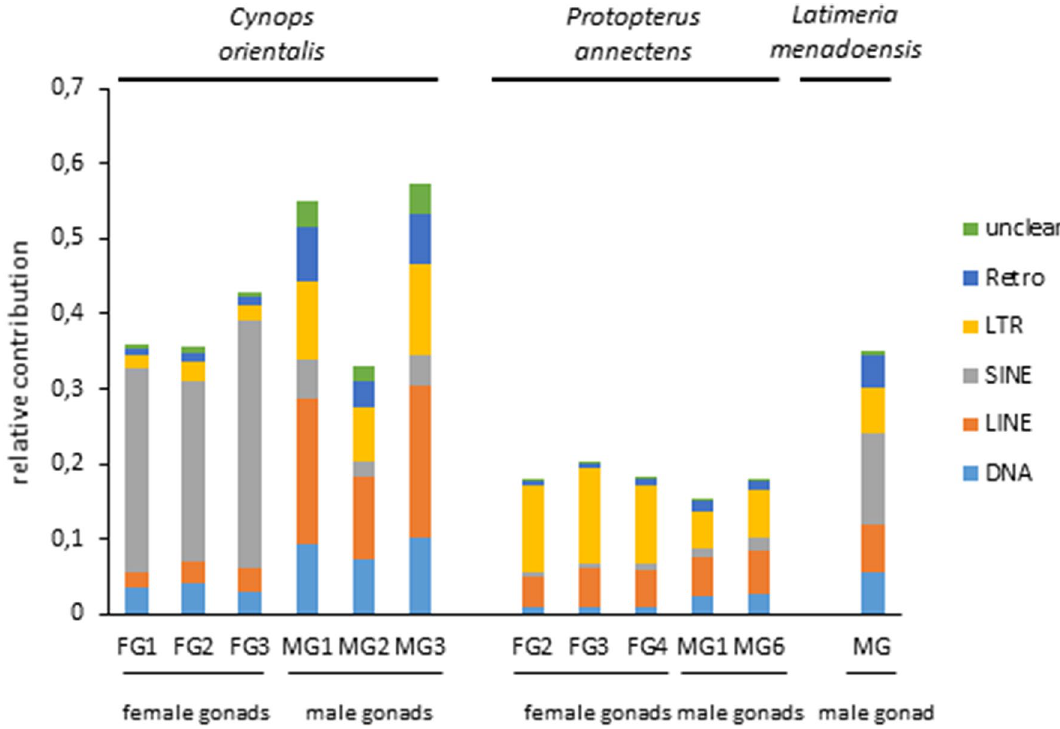
Figure 1. Relative contribution of transposon transcriptional activity in the transcriptomes obtained from gonadal tissues of Cynops orientalis, Protopterus annectens, and Latimeria menadoensis . FG female gonad, MG male